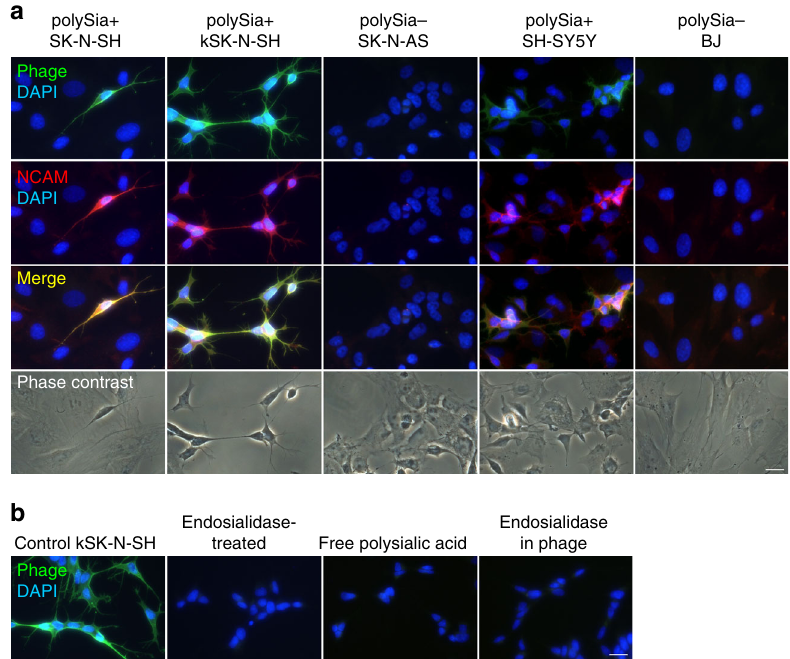
Fig. 1 Bacteriophage PK1A2 binds speci fi cally to mammalian polysialic acid-expressing cells. a Fluorescence microscopic images of cells incubated with FITC-labeled PK1A2 phages (green) and neural cell adhesion molecule NCAM antibodies (red) to assess phage surface binding. Polysialic acid-containing (polySia+) human neuroblastoma SK-N-SH, kSK-N-SH and SH-SY5Y cells as well as human polysialic acid-negative (polySia − ) neuroblastoma SK-N-AS and fi broblast BJ cells were incubated with FITC-labeled phages for 1 h at room temperature and stained for NCAM, the carrier protein of polysialic acid. b Inhibition of phage binding to kSK-N-SH cells by pretreatment with endosialidase or incubation in the presence of free polysialic acid. As a control, phage containing catalytically active endosialidase as the binding agent was used. Nuclei were stained with DAPI (blue). Representative images from two to three biological replicates are shown. The scale bars represent 20 µ